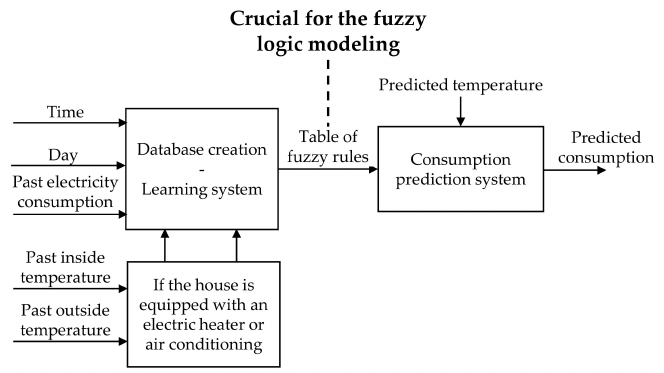
Figure 8. Diagram of the electricity prediction